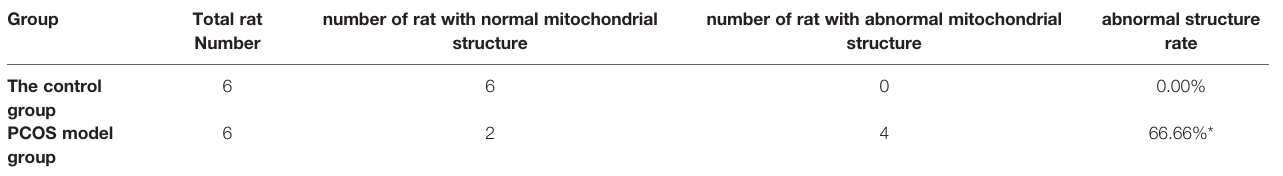
TABLE 5 | The incidence of abnormal mitochondrial structure